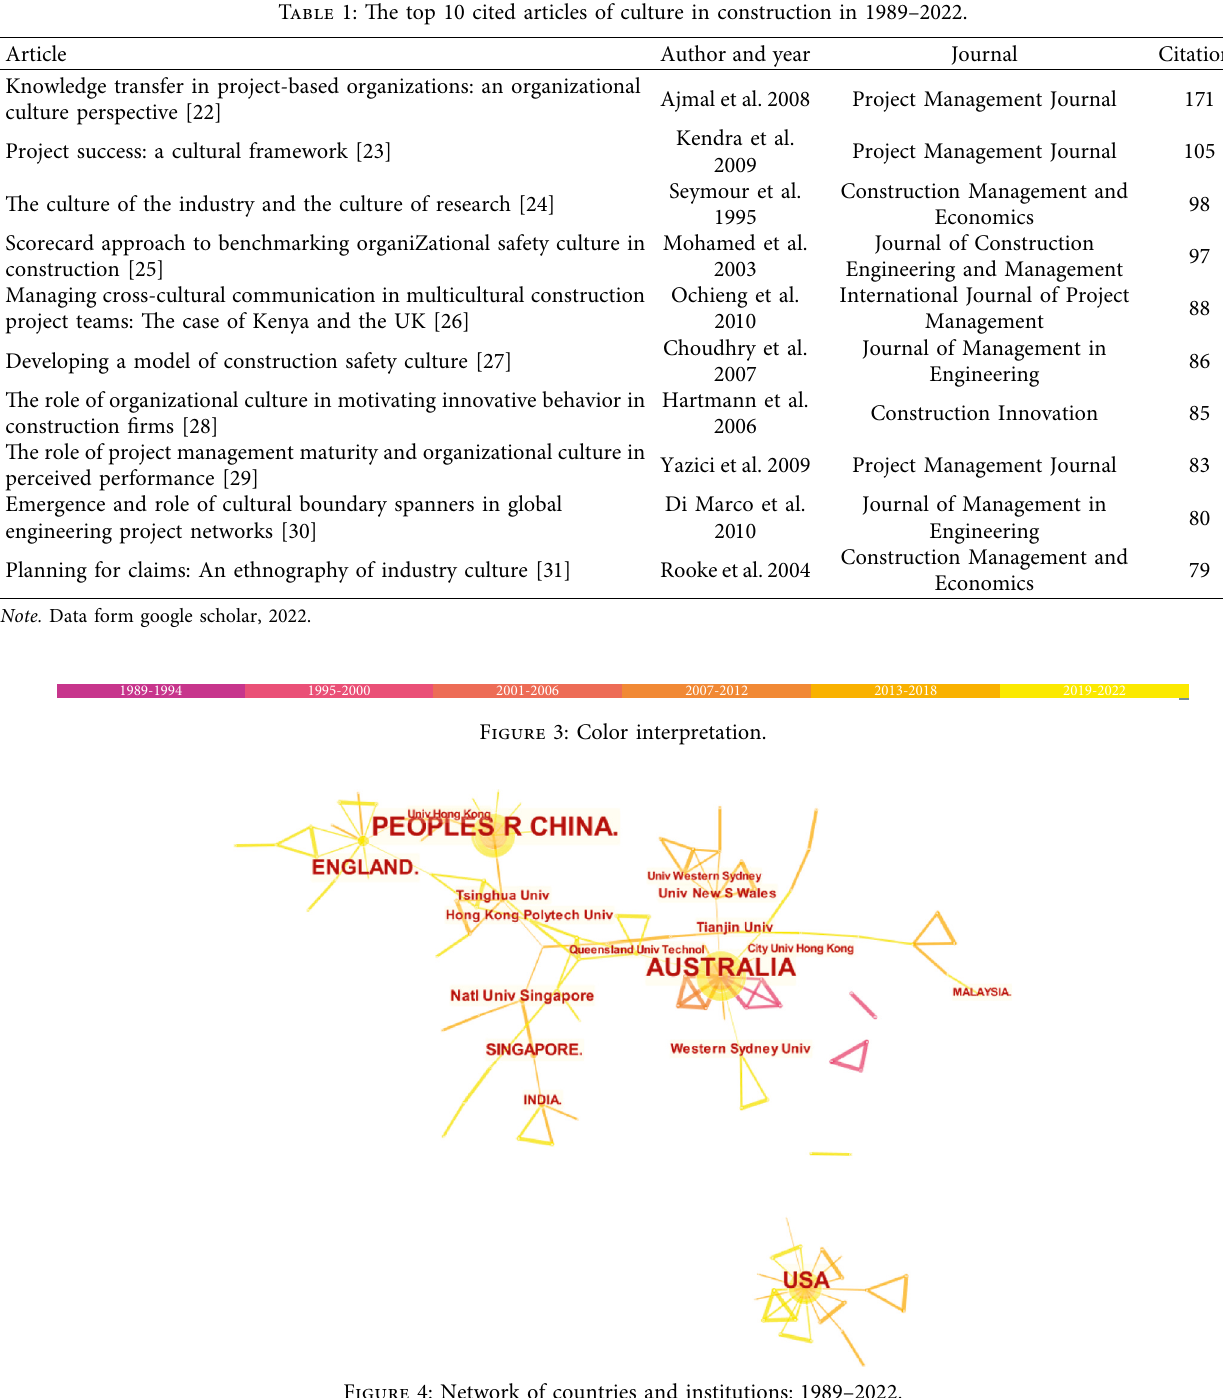
Figure 4: Network of countries and institutions: